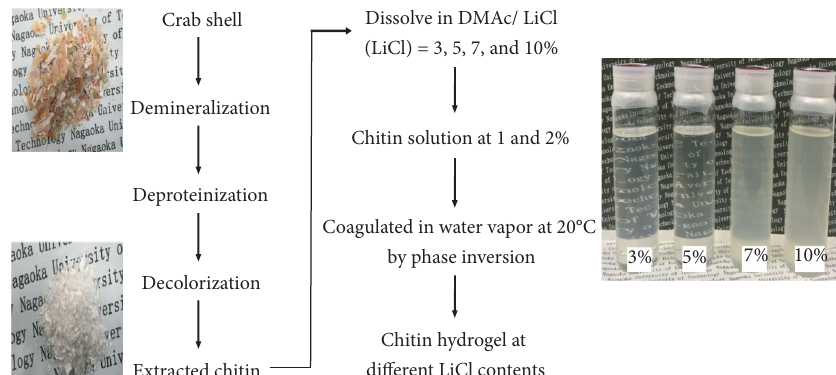
Figure 2: The preparation process of chitin, chitin-DMAc solution containing LiCl from 3 to 10% for C1-3 to C1-10, and chitin hydrogels with different LiCl